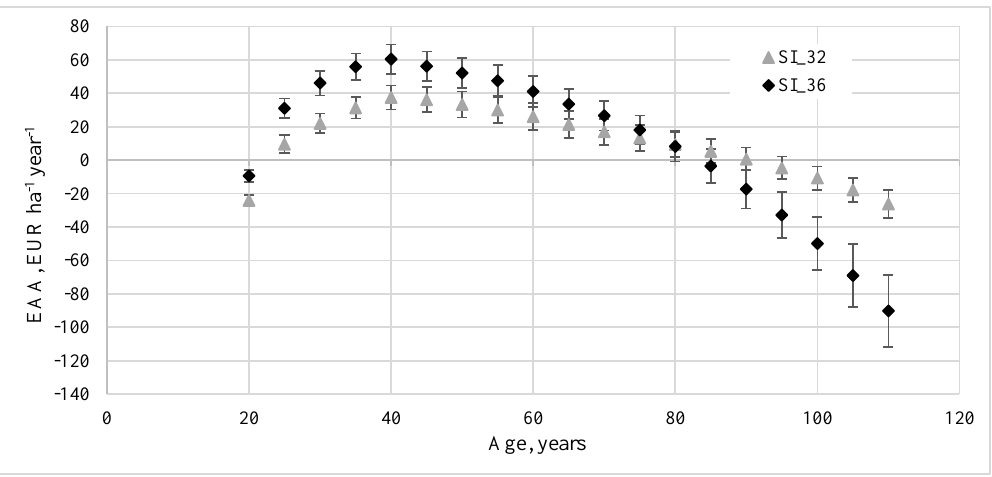
Figure 3. Equivalent annual annuity (EAA) of the planted Scots pine stands on fertile soil site index (SI) 36 and 32 at different age. Whiskers denote the 95% confidence intervals of the EAA.